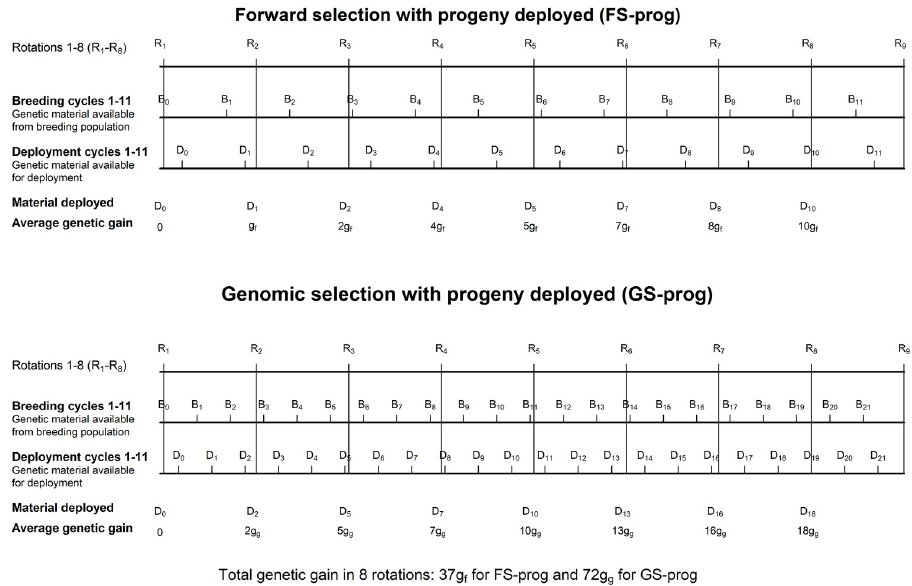
Fig 5. Diagram of calculating total genetic gain from deployment of progeny of the selected individuals for 8 rotations for forward selection (FS s ) and genomic selection (GS s ). R i is the start of i rotation with 25 years long, B i is the time when selection is made in breeding cycle i , D i is the time when genetic material is available for deployment in breeding cycle i , which is 5 years after selection in breeding cycle i . g FS s and GS s ,